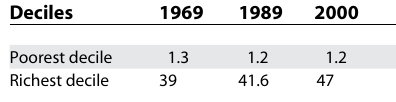
Table 2. Percentage of Total Income